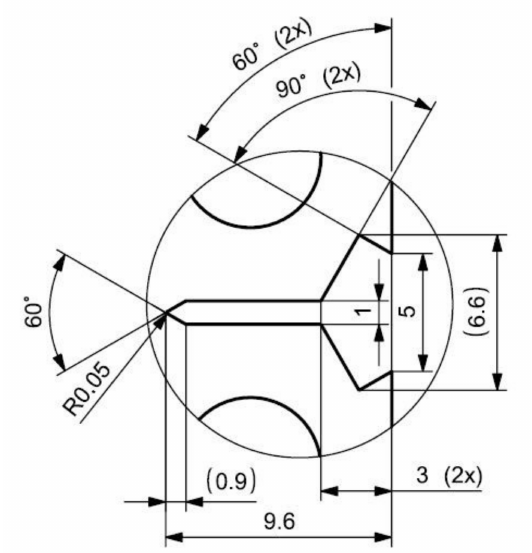
Figure 3. Crack detail of CT specimen, dimensions in